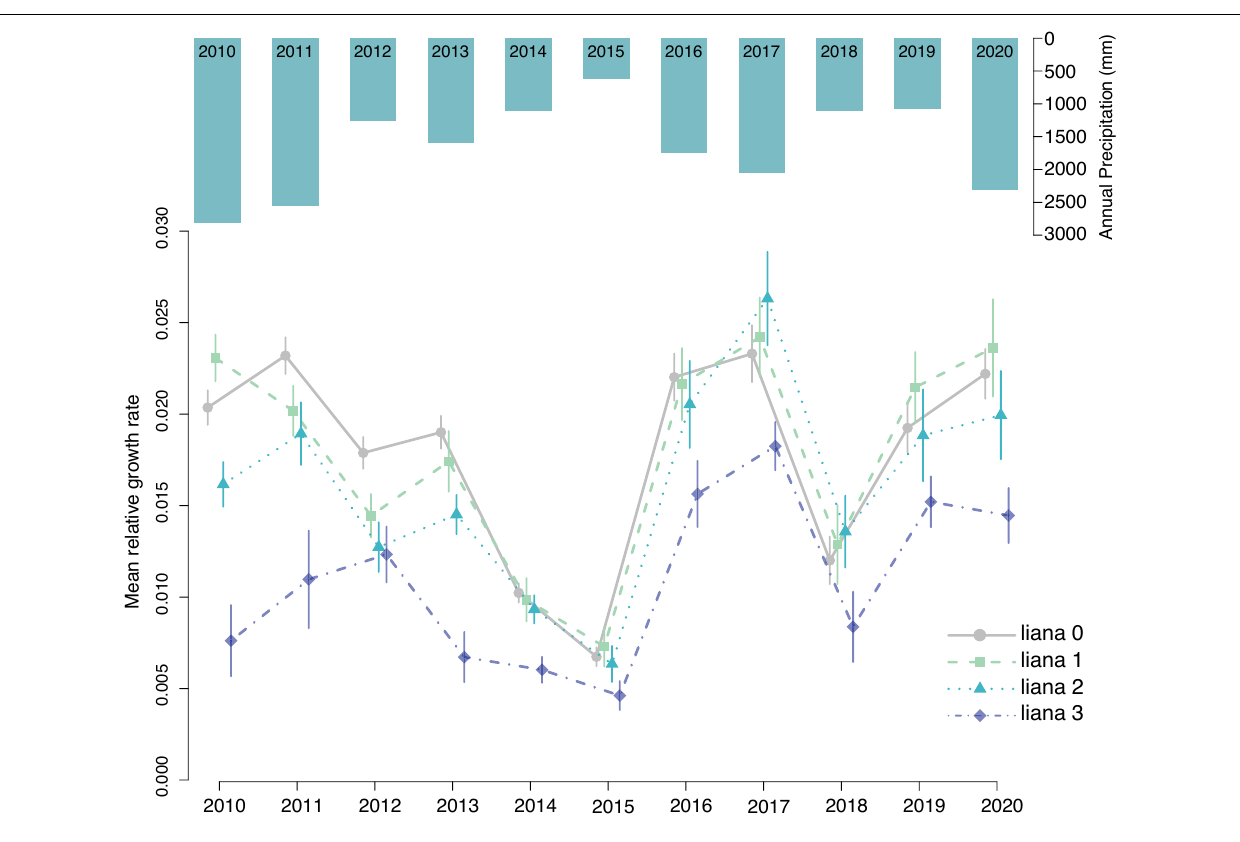
FIGURE 3 | Annual mean relative growth rate for all trees in each liana category. Error bars represent standard error. Bars at the top show annual precipitation, which is positively correlated with annual growth. While growth in all categories appears to rise and fall with precipitation, trees in category 3 show significantly lower relative growth rates and growth in these trees responded less to annual